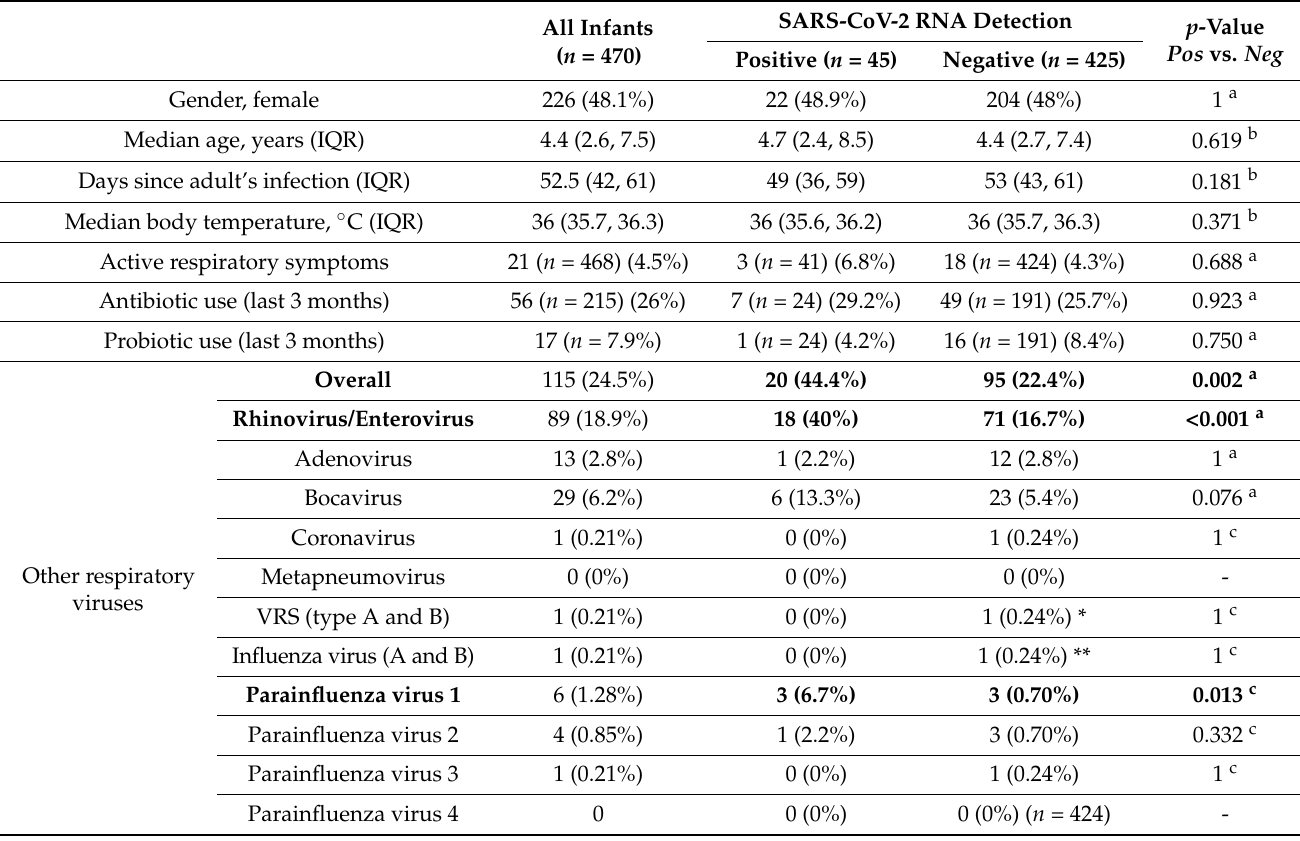
Table 1. Demographics of the pediatric population by SARS-CoV-2 RNA detection by RT-PCR. All